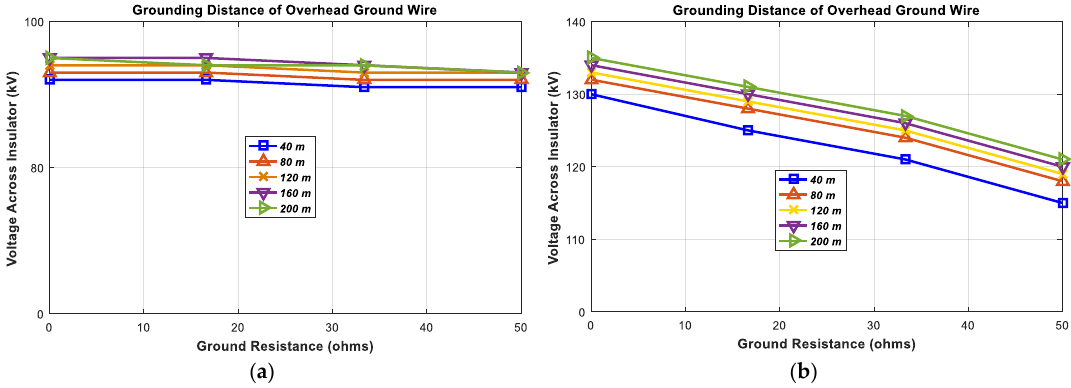
Figure 14. Voltage across the insulator as a result of a lightning strike to the phase conductor (lightning current wave shape = 4.12/77.5 μs, lightning current = 40 kA); ( a ) Strike to the middle of the phase conductor; ( b ) Strike to the end of the phase conductor.